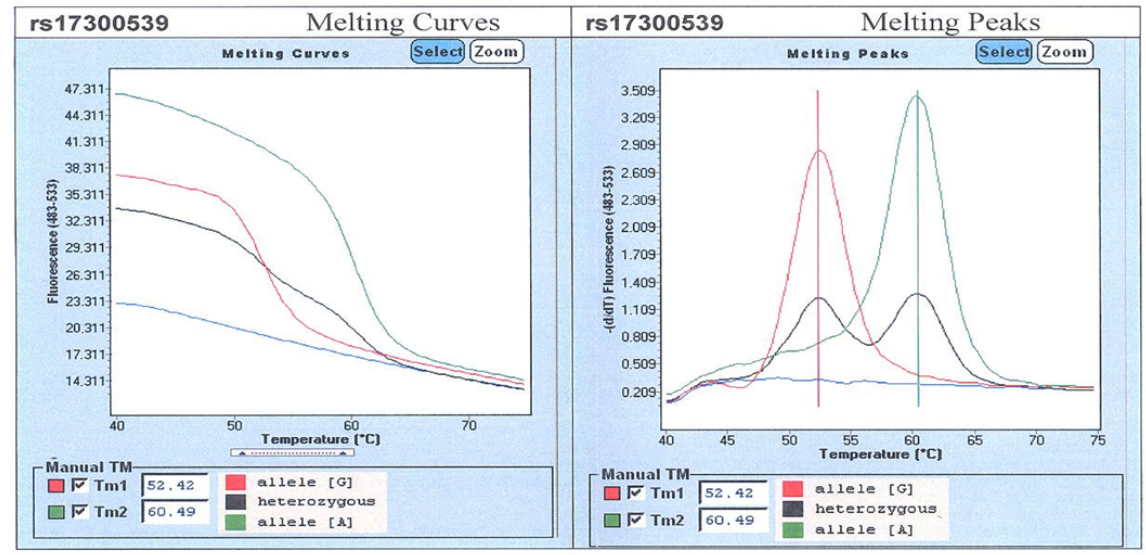
Figure 1. Analysis of the melting curves for individual alleles of ADIPOQ gene polymorphism (rs17300539).